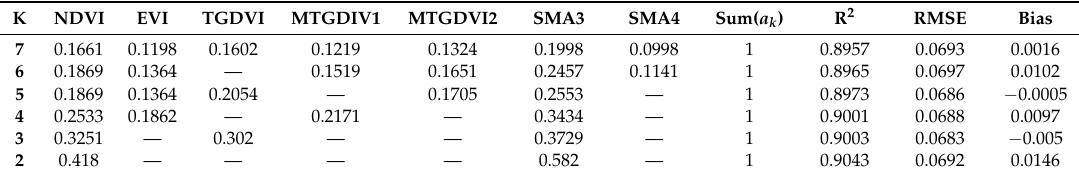
Table 3. Accuracy performances of different combinations of individual models using the BMA method (K standards for the number of individual models used in the combination